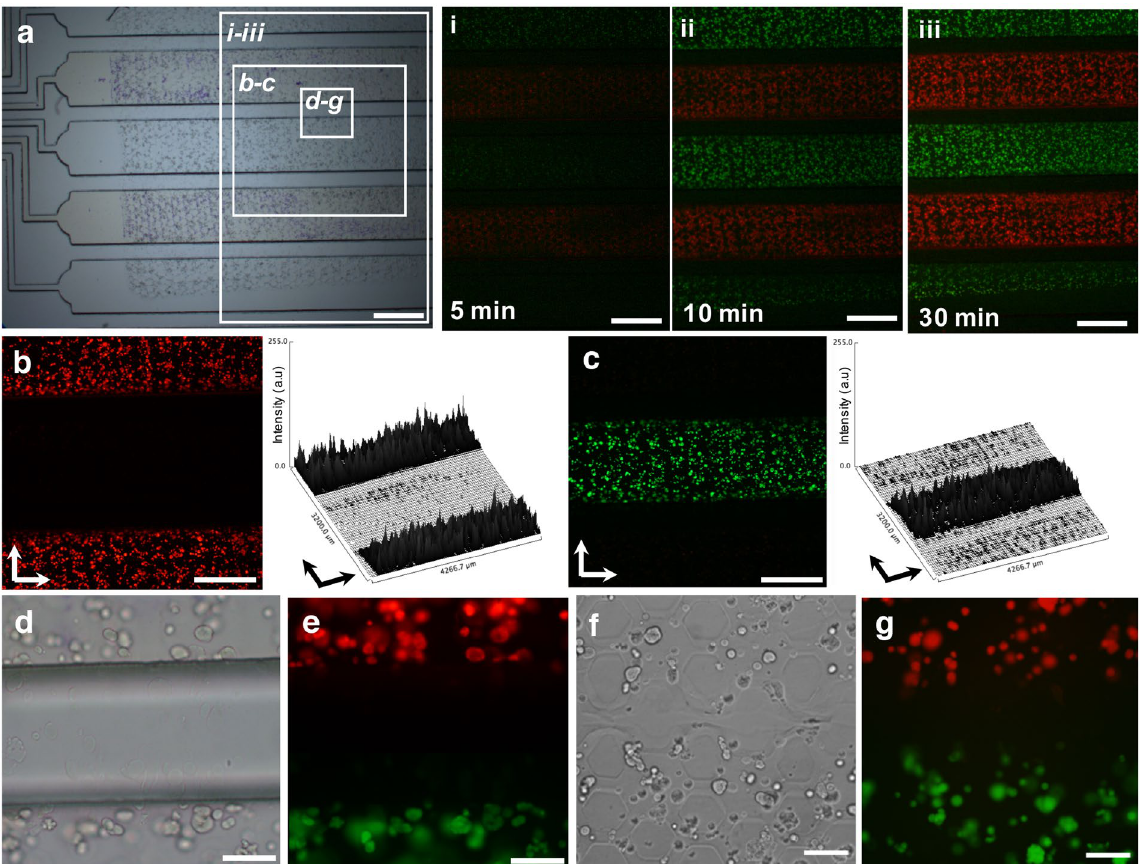
Figure 3. Leakage confirmation of the MIN6 cell-encapsulated modular sheet with two different colored CellTracker (red/green) in the microfluidic assembly platform. According to the incorporating modular sheet ( a ), encapsulated MIN6 cells were steadily stained for 5 min (i), 10 min (ii), and 30 min (iii) with a constant flow rate (40 µ L/h) via microfluidic channels. (i–iii) Time-lapse images show as indicated by the box in panel a. ( b , c ) The isolated staining of red ( b ) and green ( c ) colored MIN6 cells was assessed for leakage confirmation by fluorescence images and surface plots for their intensity. Scale bar = 1 mm. ( d – g ) Two different colors of stained MIN6 cells in the modular sheet were visualized at the border line of the two different channels under the bright field images ( d , f ) and the fluorescent images ( e , g ), when placed under microfluidic assembly platform ( d , e ) or off-microfluidic assembly platform ( f , g ). ( b – g ) Show enlarged images, as indicated by the boxes in panel a. Scale bar = 100 µ